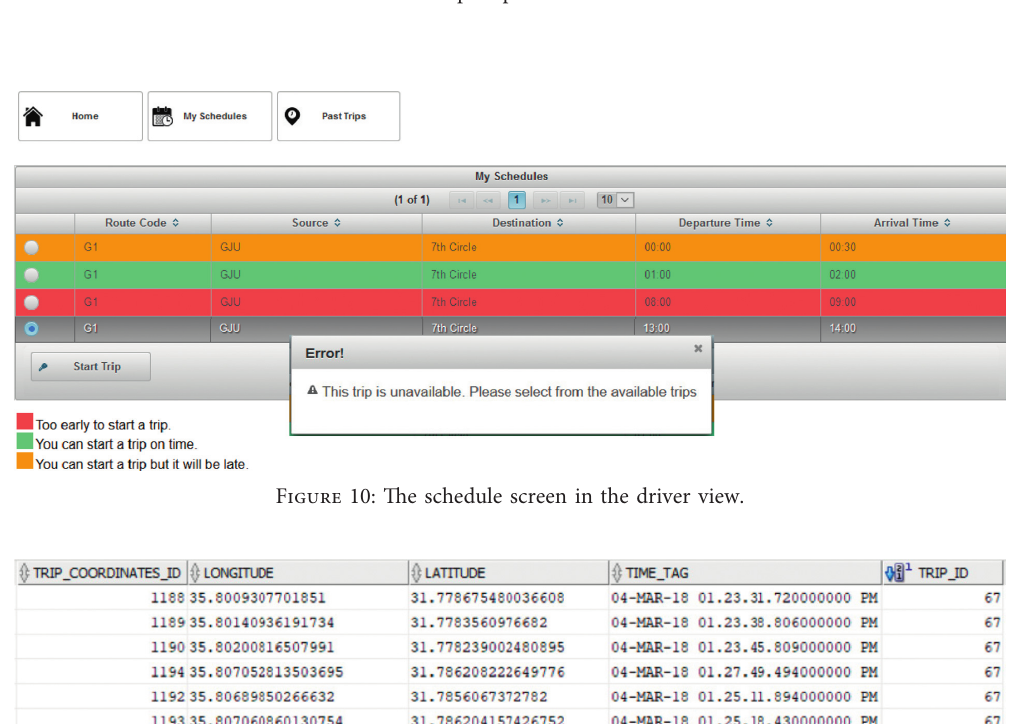
Figure 9: The trips report in the admin